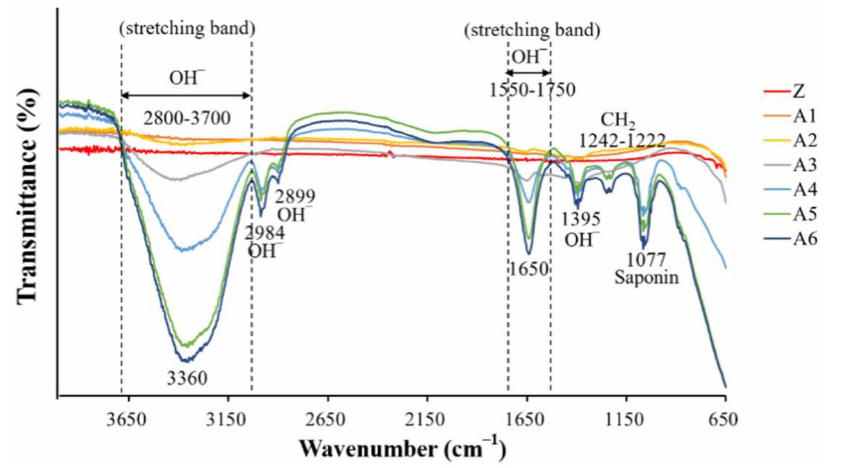
Figure 4. Fourier-transform infrared spectroscopy (FTIR). Functional groups of alkaline treatment samples were analyzed via